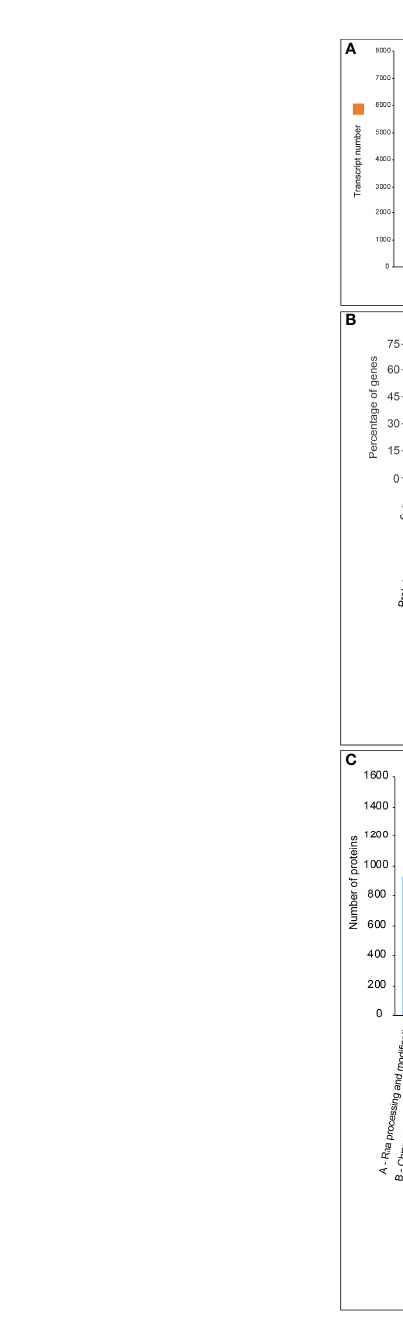
FIGURE 6 | Whole transcriptome functional annotation. (A) Number of predicted ORFs for each transcript. Orange histograms represent the number of transcripts for each number of predicted ORFs. Blue line denotes the average TPM value for each number of predicted ORFs. (B) GO functional annotation as determined by InterProScan annotation. (C) COG functional annotation assessed by